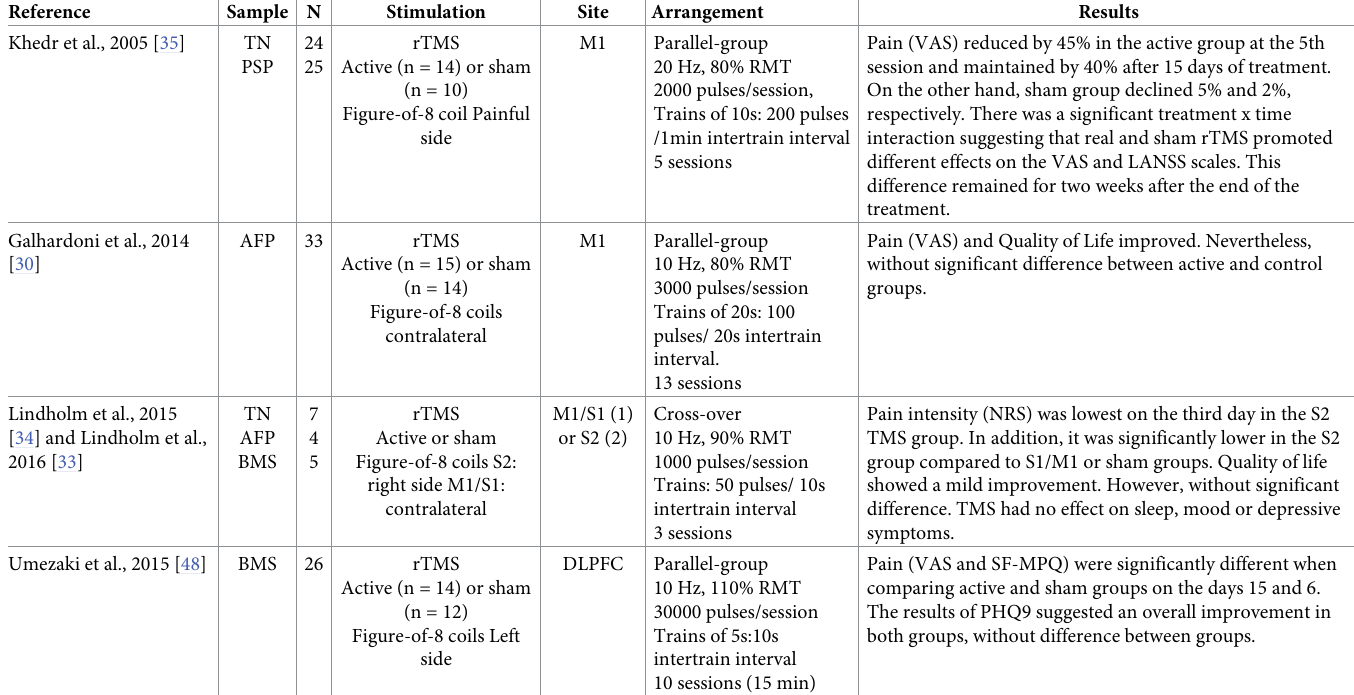
Table 4. Main findings of the TMS studies.